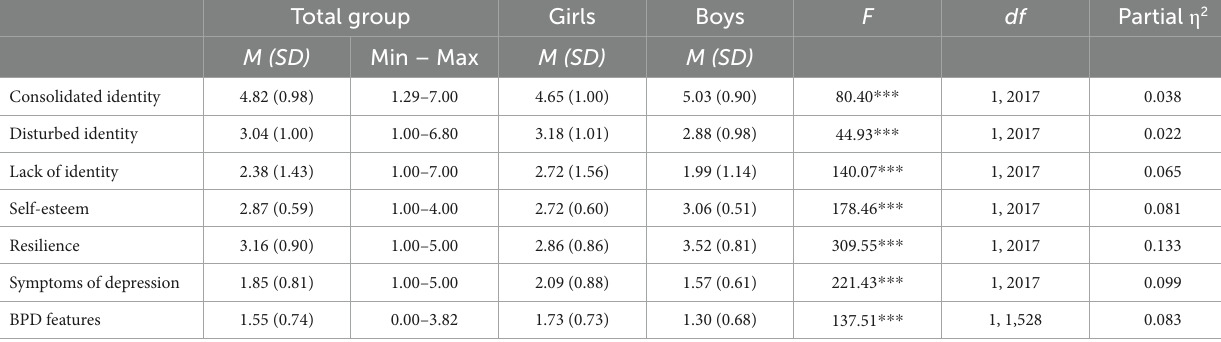
TABLE 1 Descriptive statistics and sex differences in study variables at Time